Question: Sum up the contents of this chart in one sentence.
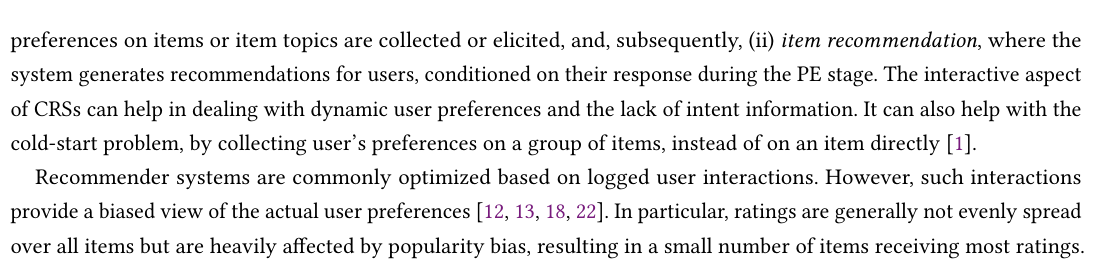
Answer: Rating distribution over item topics on the Coat Music dataset (Left), and Genre popularity in the MovieLens dataset (Right).